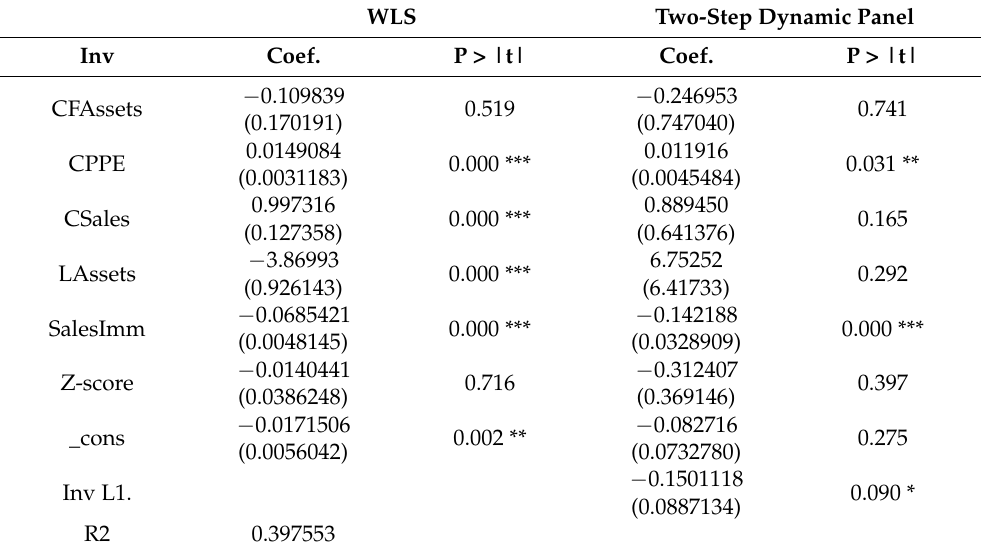
Table 1. WLS model and dynamic panel.